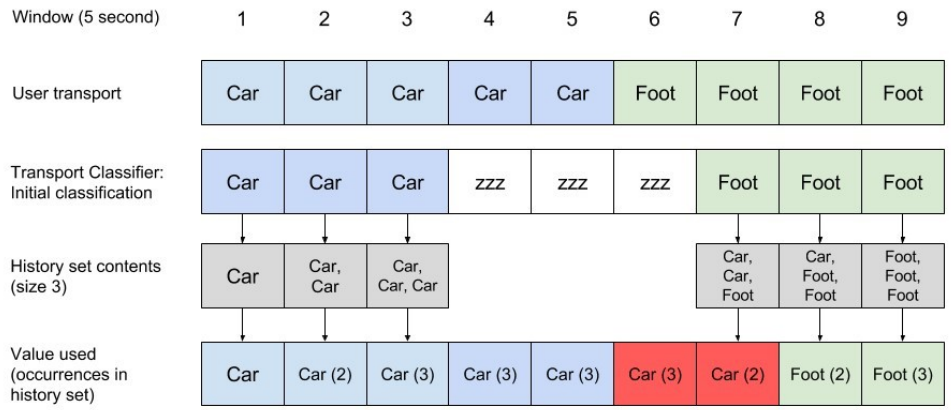
Figure 5. Historical set with serial sleep sessions. In order to maintain the battery performance during testing, the sensor sampling service within the resulting game uses an alternating sleep schedule to reduce energy consumption. The qualitative tests (using machine learning within the game) generally in- clude alternate sleeping using a 1:1 ratio of sensing and sleeping intervals (e.g., a repetitive sampling interval of 2 min followed by a sleeping interval of 2 min). This is similar to the approach shown in Figure 5. Figure 6 depicts the effect of the ratio of sensing and sleep session intervals on a number of errors.